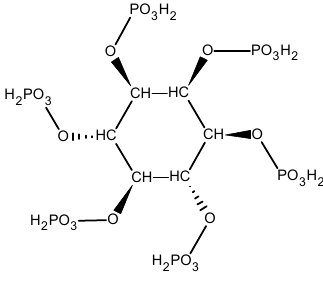
Figure 3. Structure of Phytate.